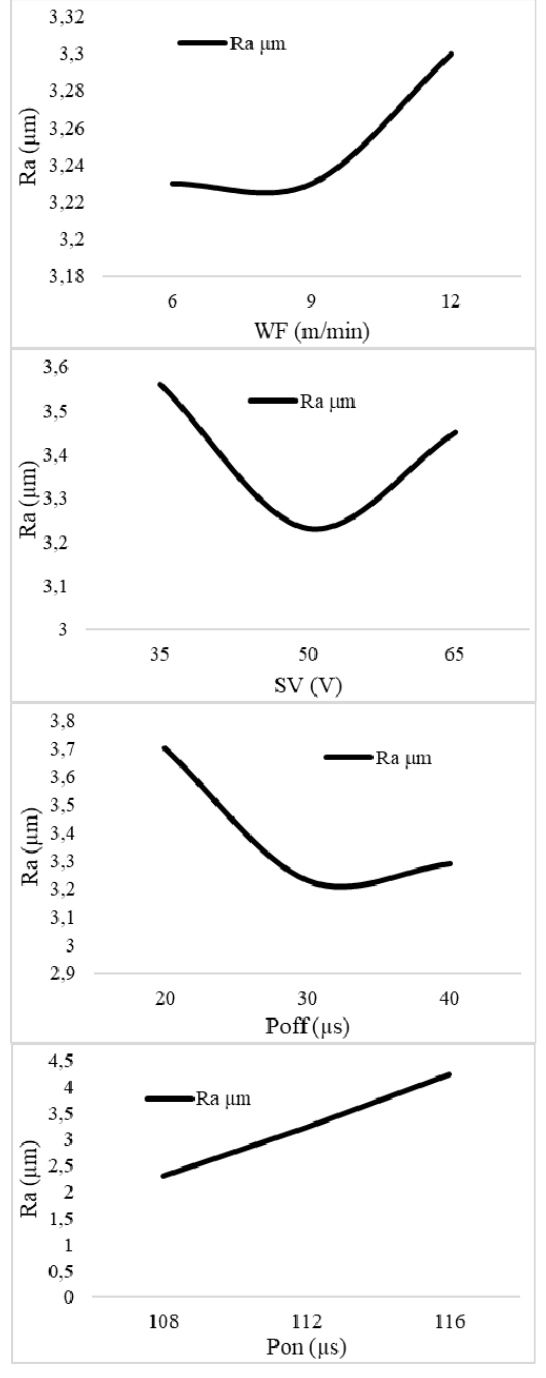
Figure 6. Variation of Ra with variable process parameters Table 3. Pooled anova for MRR Table 6. Confirmation experiments at the optimal setting suggested by